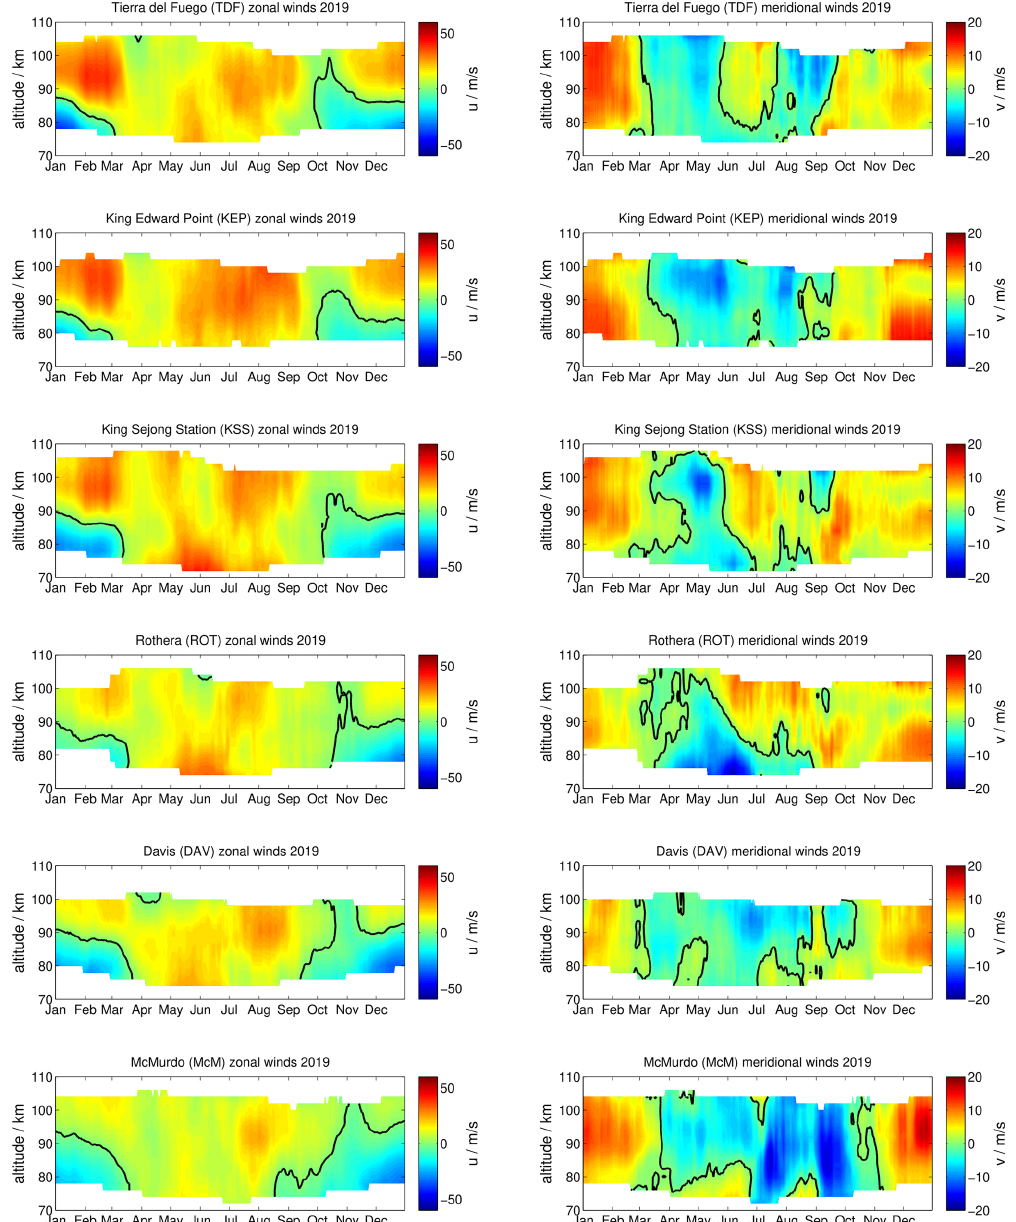
Figure 2. Comparison of zonal and meridional mean winds for each station during the year 2019. The left column shows the zonal component and the right column the meridional wind. All stations are sorted according to their latitude from TDF, KEP, KSS, ROT, and DAV to